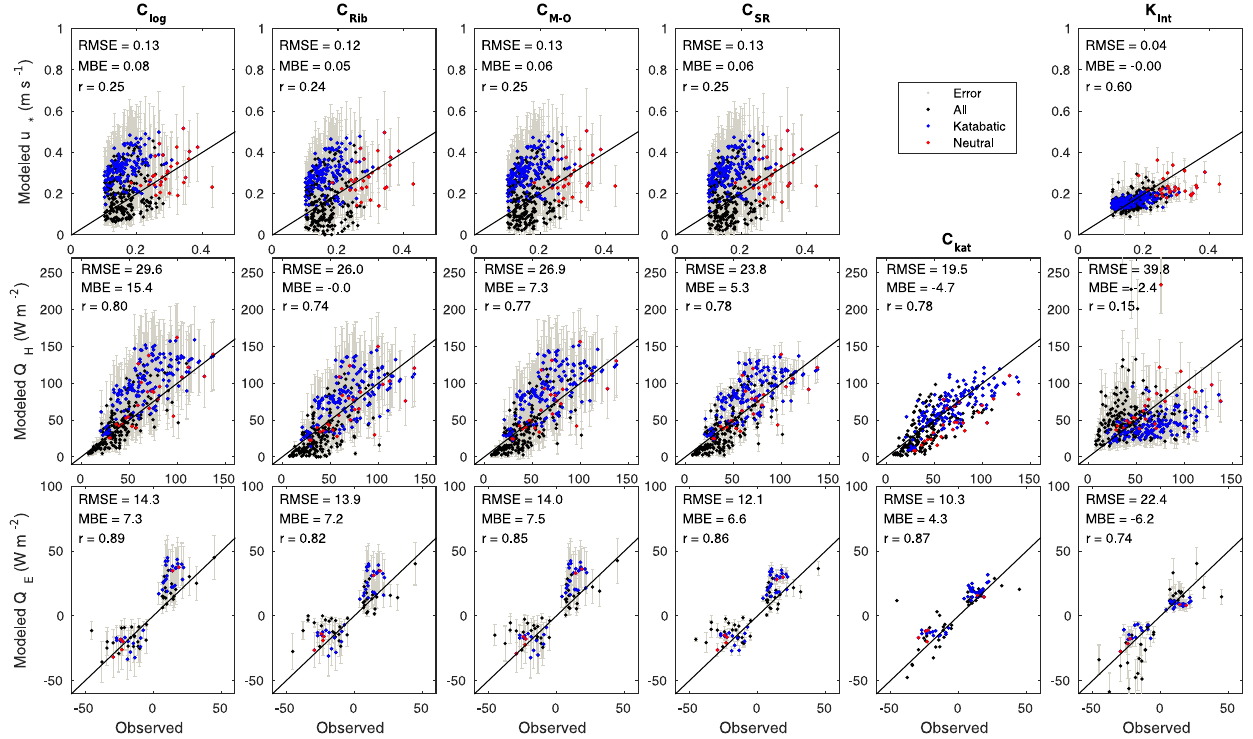
Figure 4. Comparison of 30min observed (OPEC-derived) vs. modeled friction velocity ( u ∗ ), sensible-heat flux ( Q H ), and latent-heat flux ( Q E ), according to the six bulk methods: C log , C Ri standard deviation of Monte Carlo ensembles (see text). No error bars are given for the C kat method since it is independent of roughness lengths. Red points denote values during the near-neutral conditions flow. Root mean square error (RMSE; Wm − 2 ), mean bias error (MBE; Wm − 2 ), and Pearson correlation coefficient ( r ) are provided for each scatterplot.